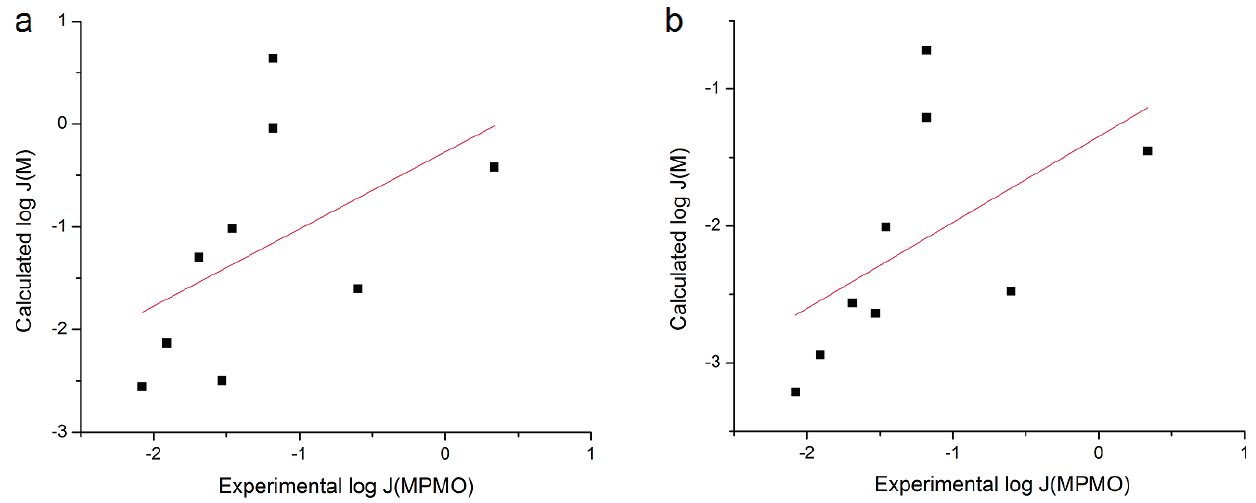
calculated with Prybylski, et al. coefficients [2] from the n = 55 M using ( a ) S or ( b ) S MPMO 7.4 1.0